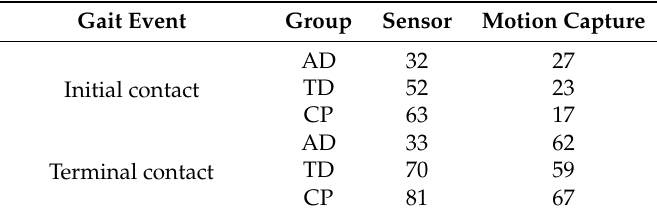
Table 5. Root mean square error (RMSE) of gait event detection (ms) of shank angular velocity versus gold standard for sensor and motion capture systems. The sensor system used a gyroscope signal [5,50]. AD: adult; TD: typically developing children; CP: children with cerebral palsy. Gait Event